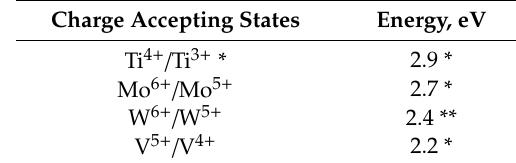
Figure 10. EPR spectra of TiO 2 /V 2 O 5 photocatalyst before ( a ) and after 10 min ( b ) of UV light illumination.